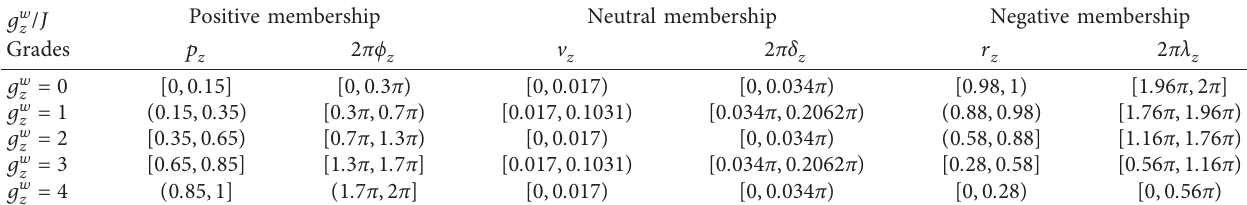
Table 3: Grading